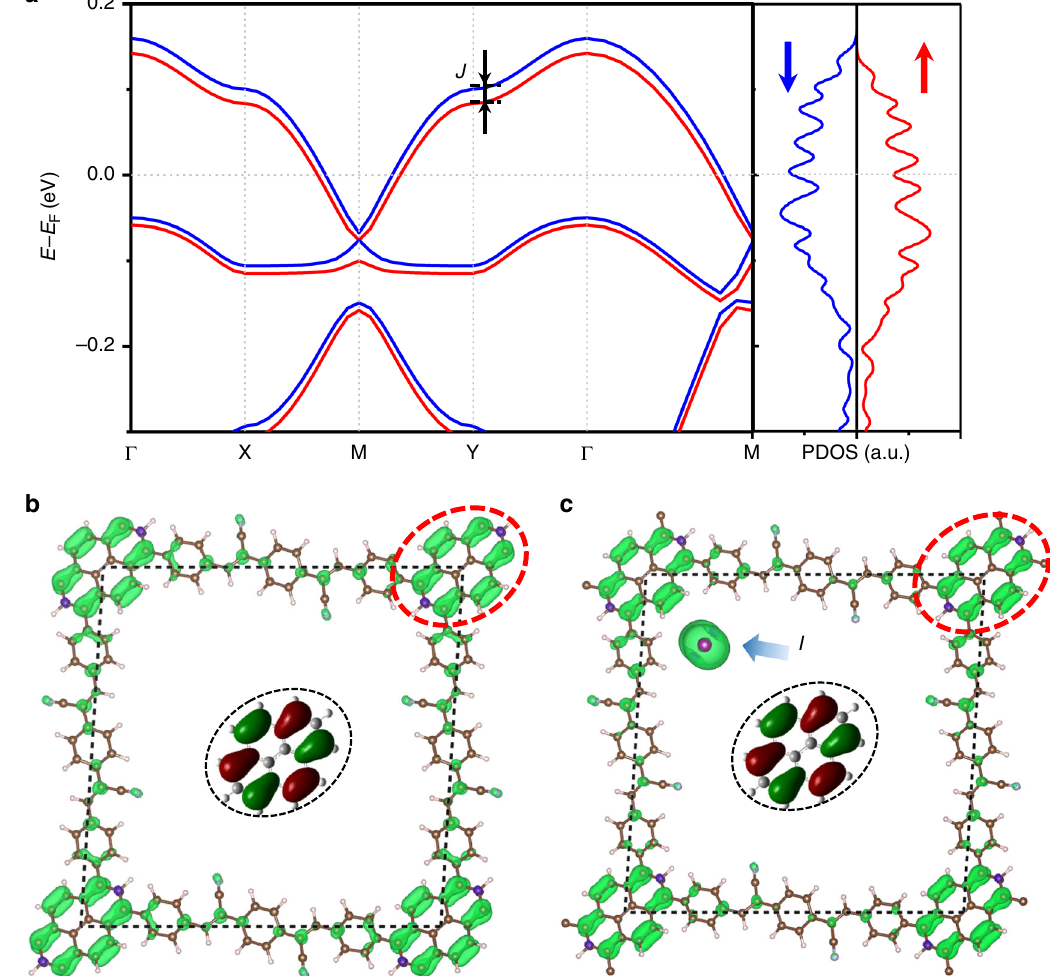
Fig. 4 Magnetism in Py(BCSB) 2 . a Spin-polarized electronic band structure and PDOS of the hole-doped Py(BCSB) 2 . Spin distribution of b the hole-doped and c the iodine-doped Py(BCSB) 2 with iodine (highlighted by blue arrow) sitting at the off-corner site. Inset shows the HOMO of